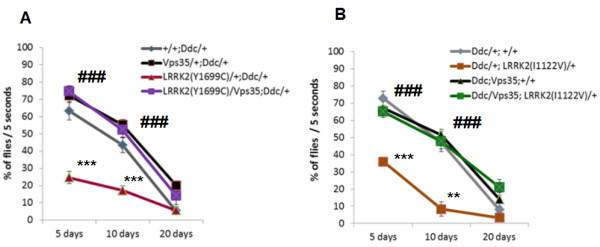
Overexpression of Vps35 in DA neurons rescues locomotor deficits of other PD mutants. (A) Overexpression of Vps35 in LRRK2(Y1699C) mutants.(B) Overexpression of Vps35 in LRRK2(I1122V) mutants. All flies were reared at 29°C. N = 3-7 cohorts of ten. Statistical analysis: Two-Way ANOVA, Tukey’s post-test. Statistically significant difference compared to control (Ddc alone) is denoted as ** for P < 0.001, or *** for P < 0.0001. Statistically significant difference compared to Ddc/+;LRRK2(I2020T)/+is denoted as ### for P < 0.0001.